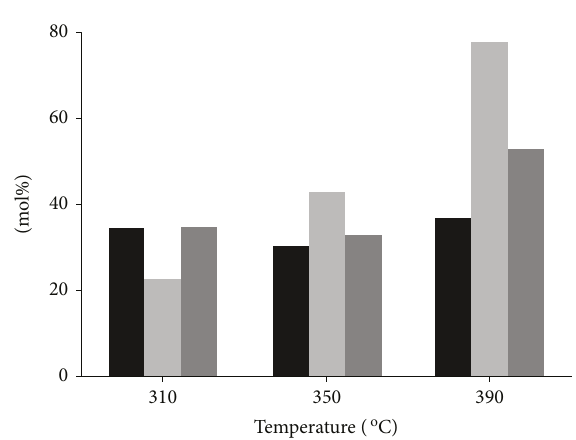
Figure 5: Comparative catalytic activity in samples hydrotreated by FTIR at di ff erent temperatures and WHSV with platinum-loaded 20% USY/Al O catalyst. (black square) 0.01% Pt WHSV = 2 3 176.4h − 1 ; (light gray square) 0.01% Pt WHSV=35.28h − 1 ; and (dark gray square) 0.05% Pt WHSV =35.28h − 1 .